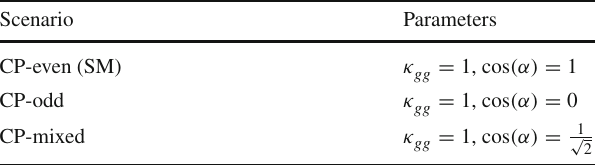
Table 1 Definition of the three benchmark scenarios used in the ggF + 2 jets analysis. The parameter settings correspond to a CP-even (i.e. the SM hypothesis), a CP-odd, and a CP-mixed scenario